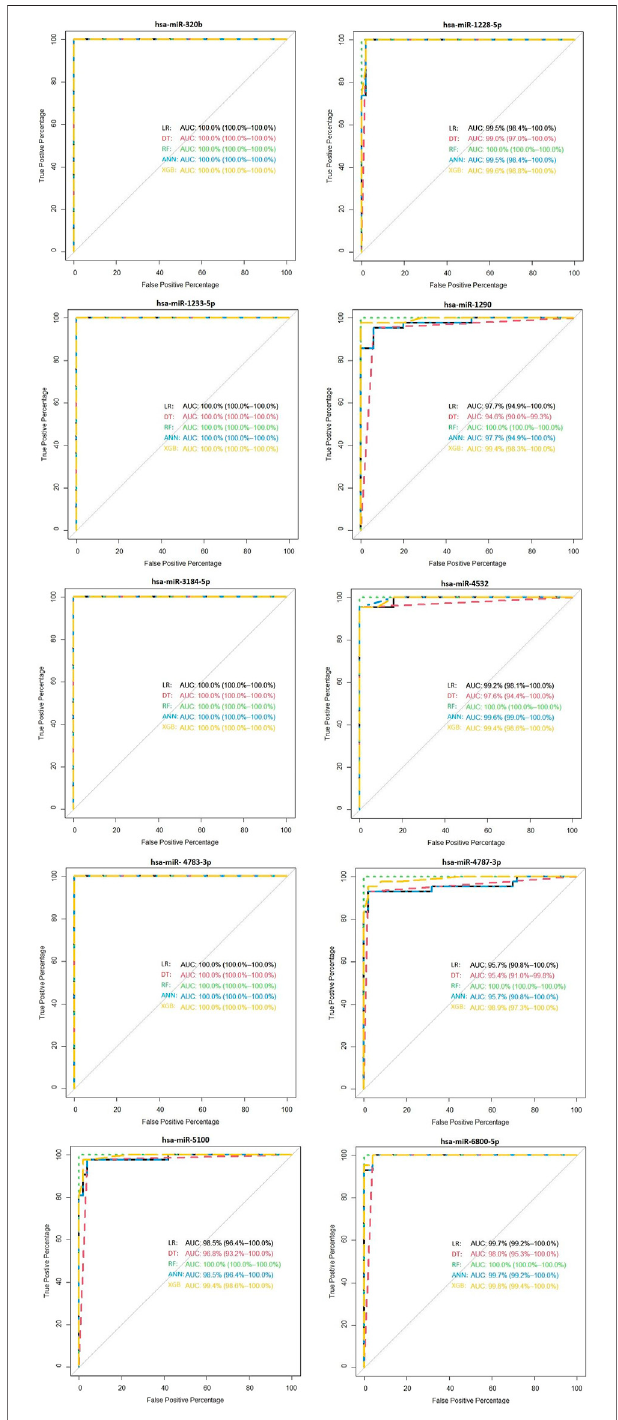
FIGURE 7 | Validation of the diagnostic performance of the three selected miRNA high signatures in the external (GSE113486) data.